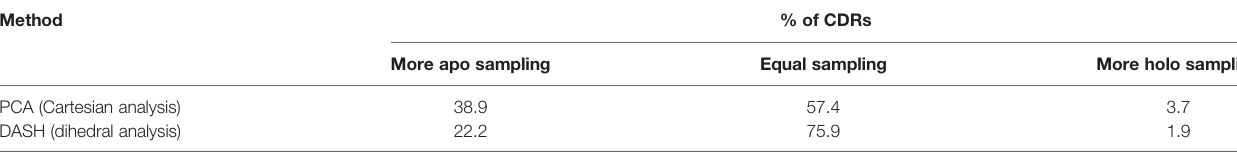
Percentages are rounded to one decimal